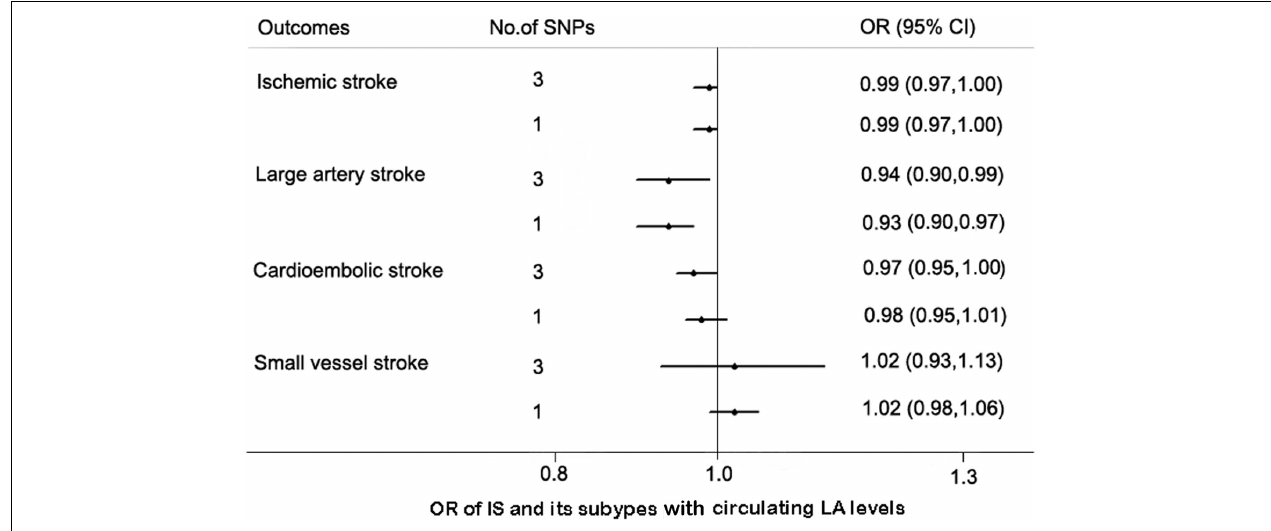
FIGURE 2 | MR estimates between the association of linoleic acid (LA) and ischemic stroke (IS) with its subtypes by additional IV sets. Abbreviation: CI, confidence interval; OR, odds ratio.